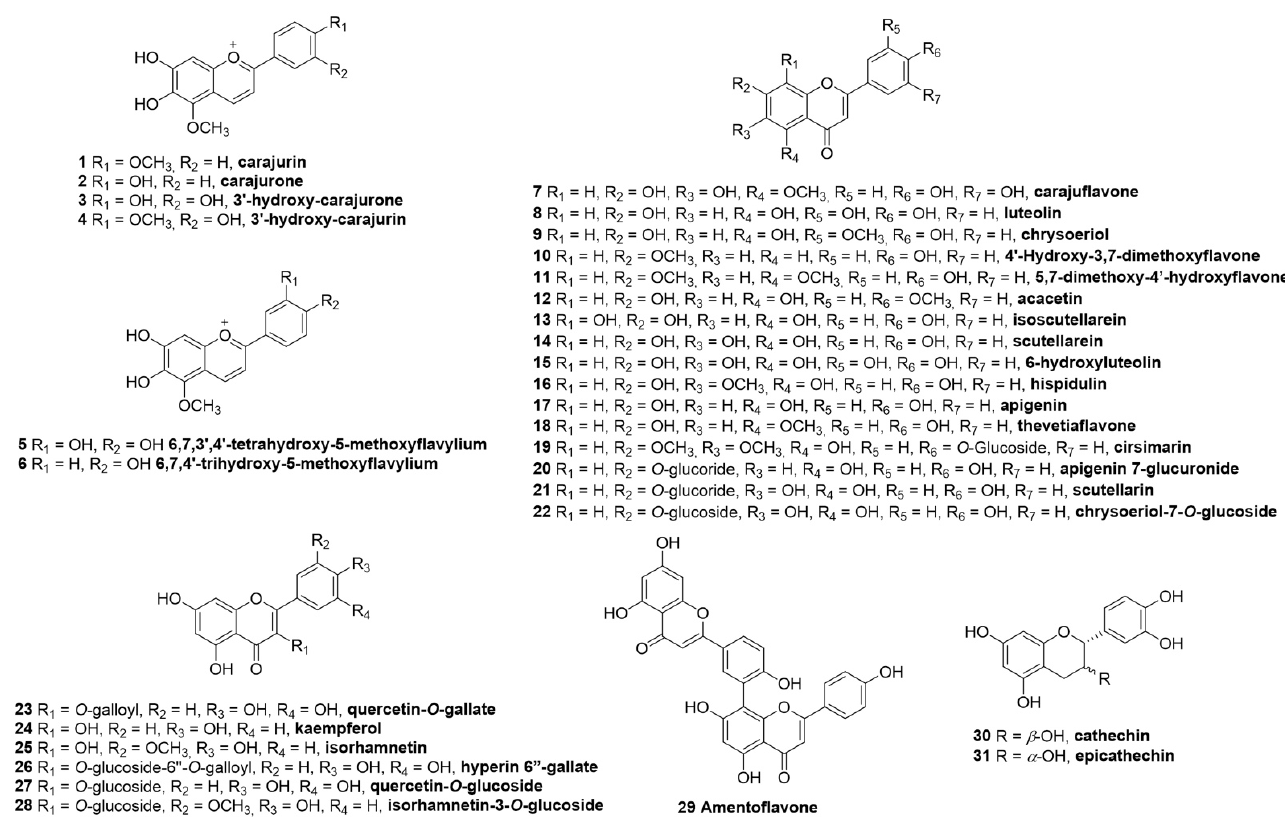
Figure 2. Polyphenols ( 1 – 31 ) of F. chica . Table 1. Phytochemical components of F. chica extracts and their biological